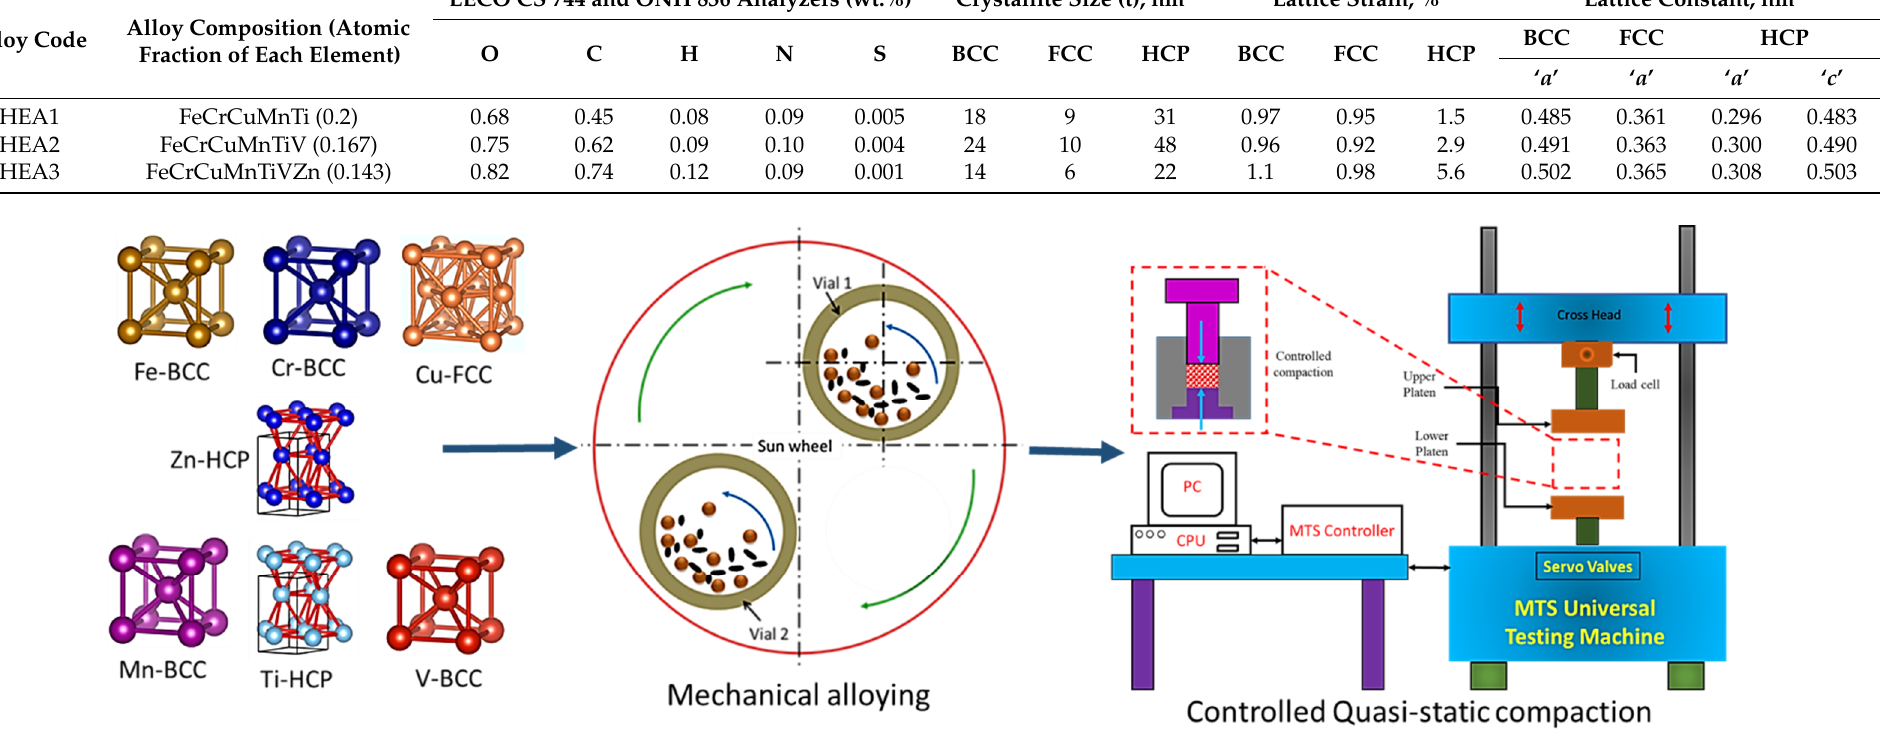
Figure 1. Schematic showing the present research work to synthesize and investigate the densification behavior of three high entropy alloys.